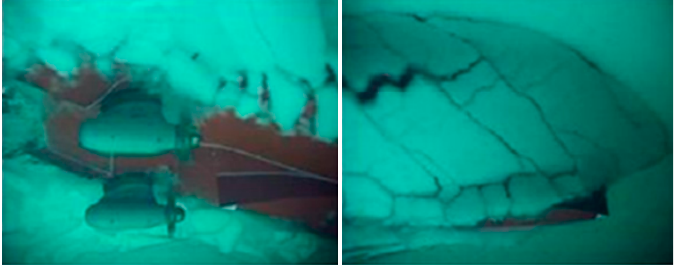
Figure 3. The motion of broken ice in a test.